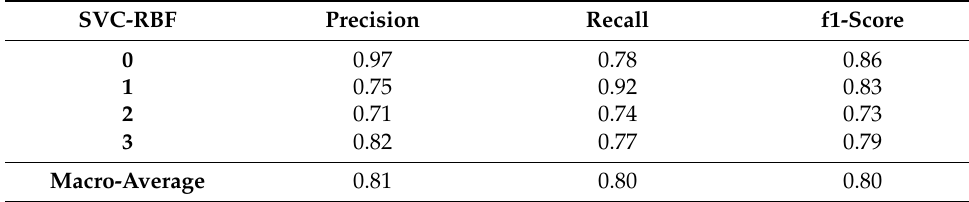
Table 8. Performance of SVC-RBF.